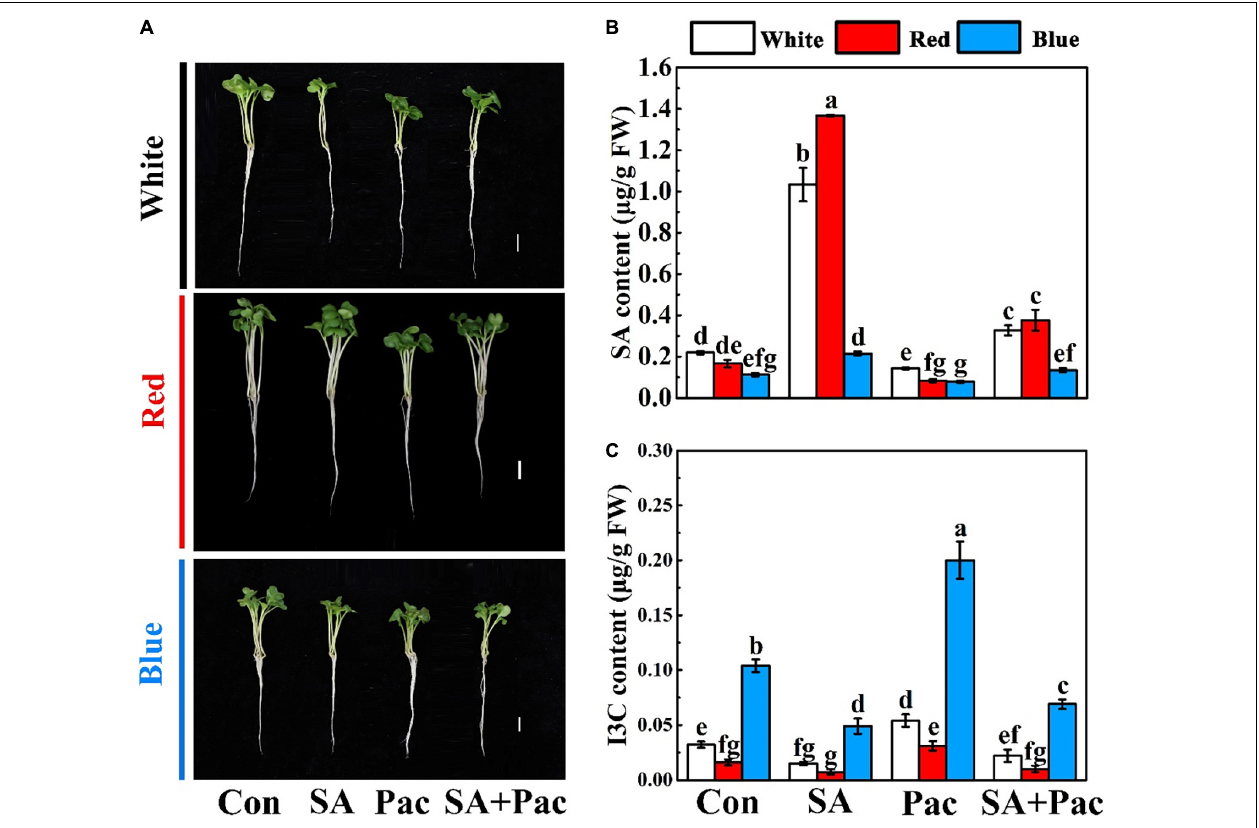
FIGURE 2 | Experiment of exogenous SA treatment. (A) The phenotypes under white light, red light, and blue light, respectively. The effect of SA, Pac, and their combination treatments on phenotype under different light. 3-days-old sprouts grown hydroponically were treated with nutrient solution only (Con), 40 µ M